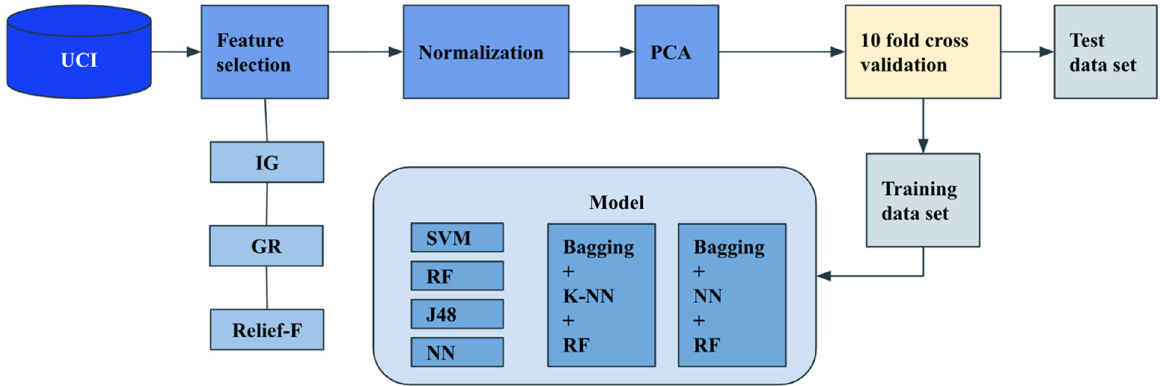
Figure 4. Hybrid algorithms for phishing detection. Information Gain (IG), Gain Ratio (GR), and Relief-F are widely used feature selection algorithms. Principal components analysis (PCA) is a reducing dimension technology by transforming data points coordinates. The UCI dataset [22] is a public phishing dataset. Support Vector Machine (SVM), Random Forest (RF), neural network (NN), and k-nearest neighbors (K-NN) are classifiers.